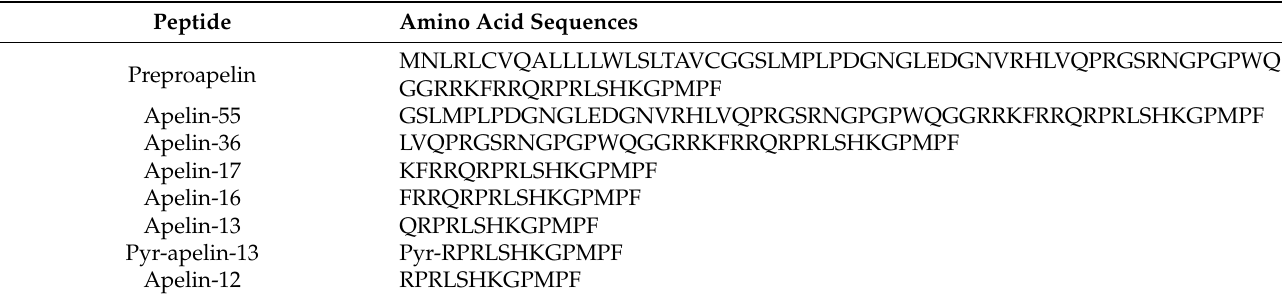
Table 1. Amino acid sequences of apelin peptides.